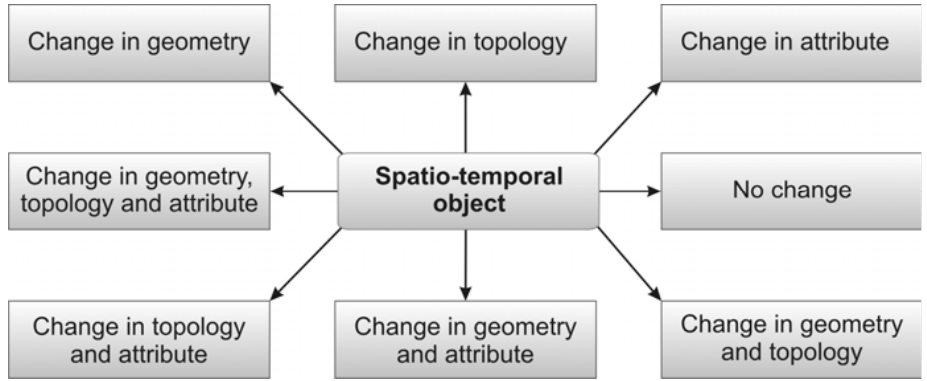
Figure 1. Possible types of changes of a spatio-temporal object. Modified after [11].